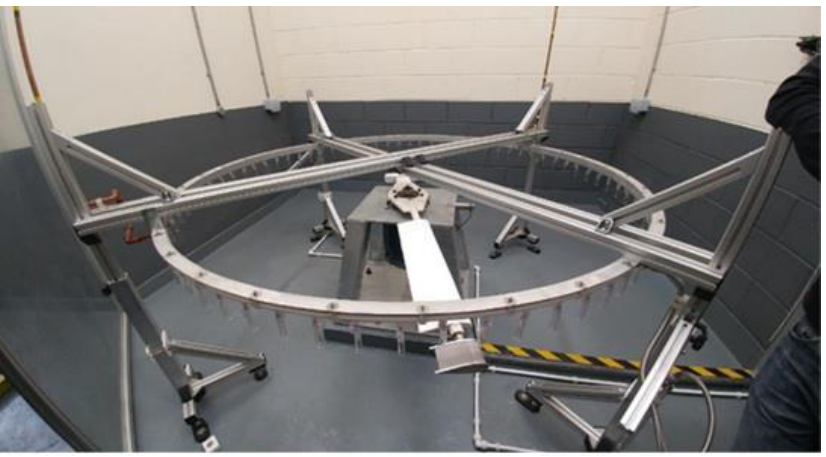
Figure 2. Rain Erosion Test (RET) rig at ETC, East Kilbride.